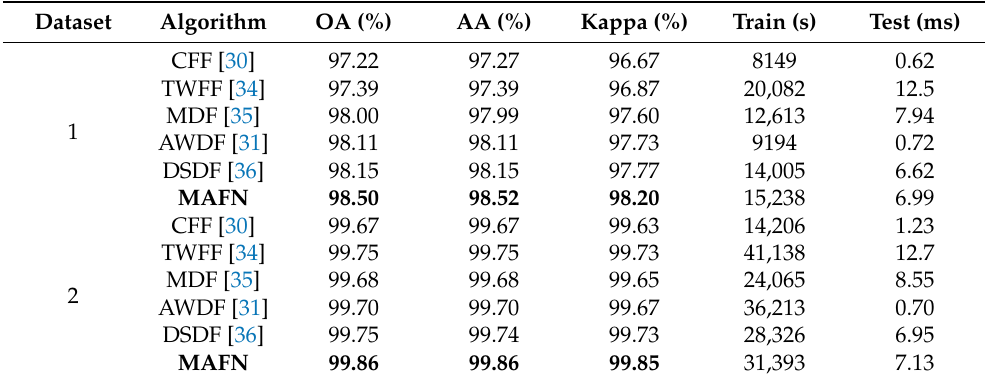
Table 5. Comparison results of MAFN with other fusion algorithms